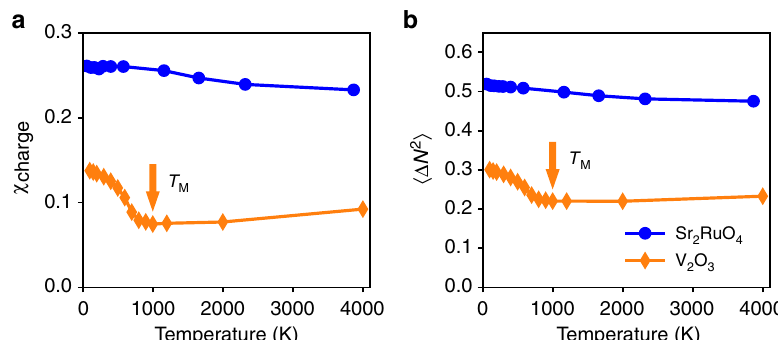
Fig. 3 The static local charge susceptibility χ charge , and local charge fl uctuation 〈 Δ N 2 〉 . ( a ) χ charge and ( b ) 〈 Δ N 2 〉 is computed for V 2 O 3 (orange diamonds) and Sr 2 RuO 4 (blue circles). In the Hund system Sr 2 RuO 4 both χ charge and 〈 Δ N 2 〉 are large and only weakly dependent on temperature. By contrast, in the Mott system V 2 O 3 they are much smaller and strongly temperature dependent. The orange arrows indicate that in V 2 O 3 the minima of the local charge susceptibility and fl uctuation occur at the same temperature scale, T M , as that marking the emergence of the quasiparticle peak in the local PDOS